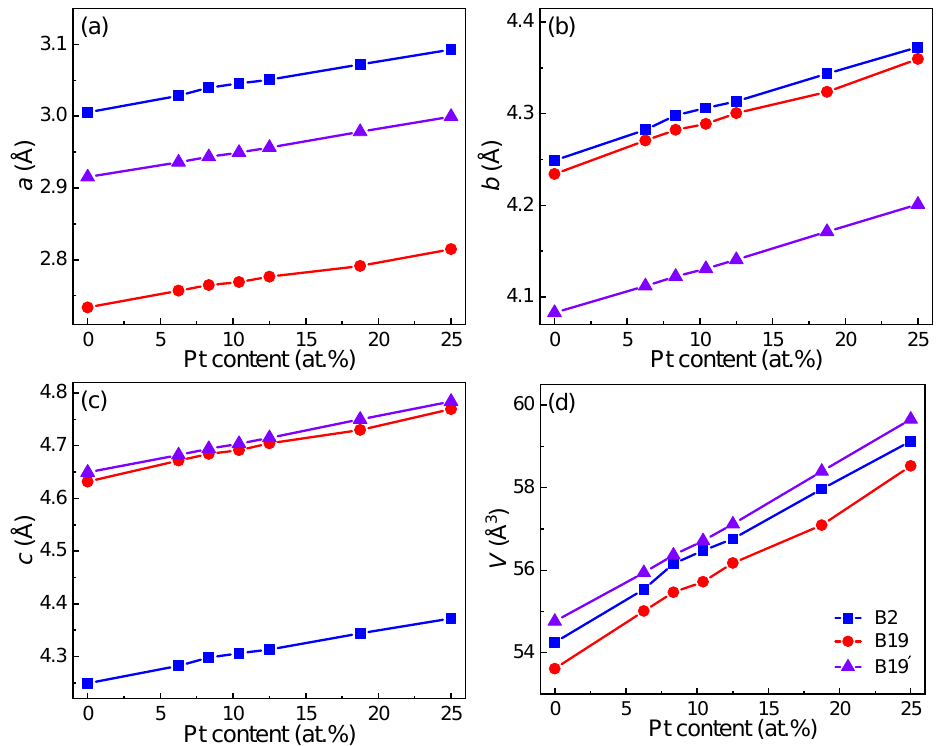
Figure 3. Pt content dependence of ( a ) ‘ a ’ lattice parameter, ( b ) ‘ b ’ lattice parameter ( c ) ‘ c ’ lattice parameter, and ( d ) unit cell volume in B2, B19 and B19 (cid:48) structures of Ti 50 Ni 50 − x Pt x